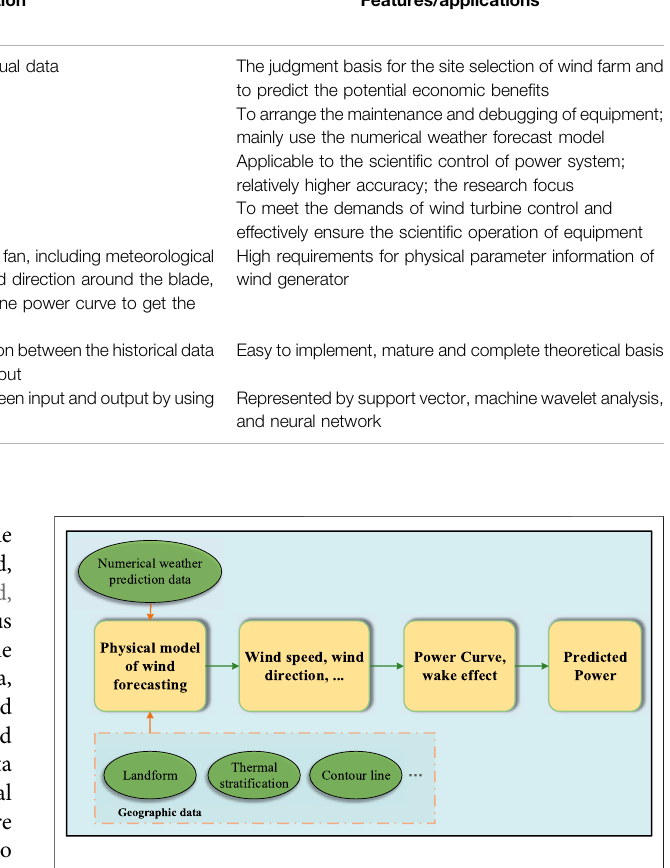
FIGURE 1 | Process of the wind speed and power prediction based on physical